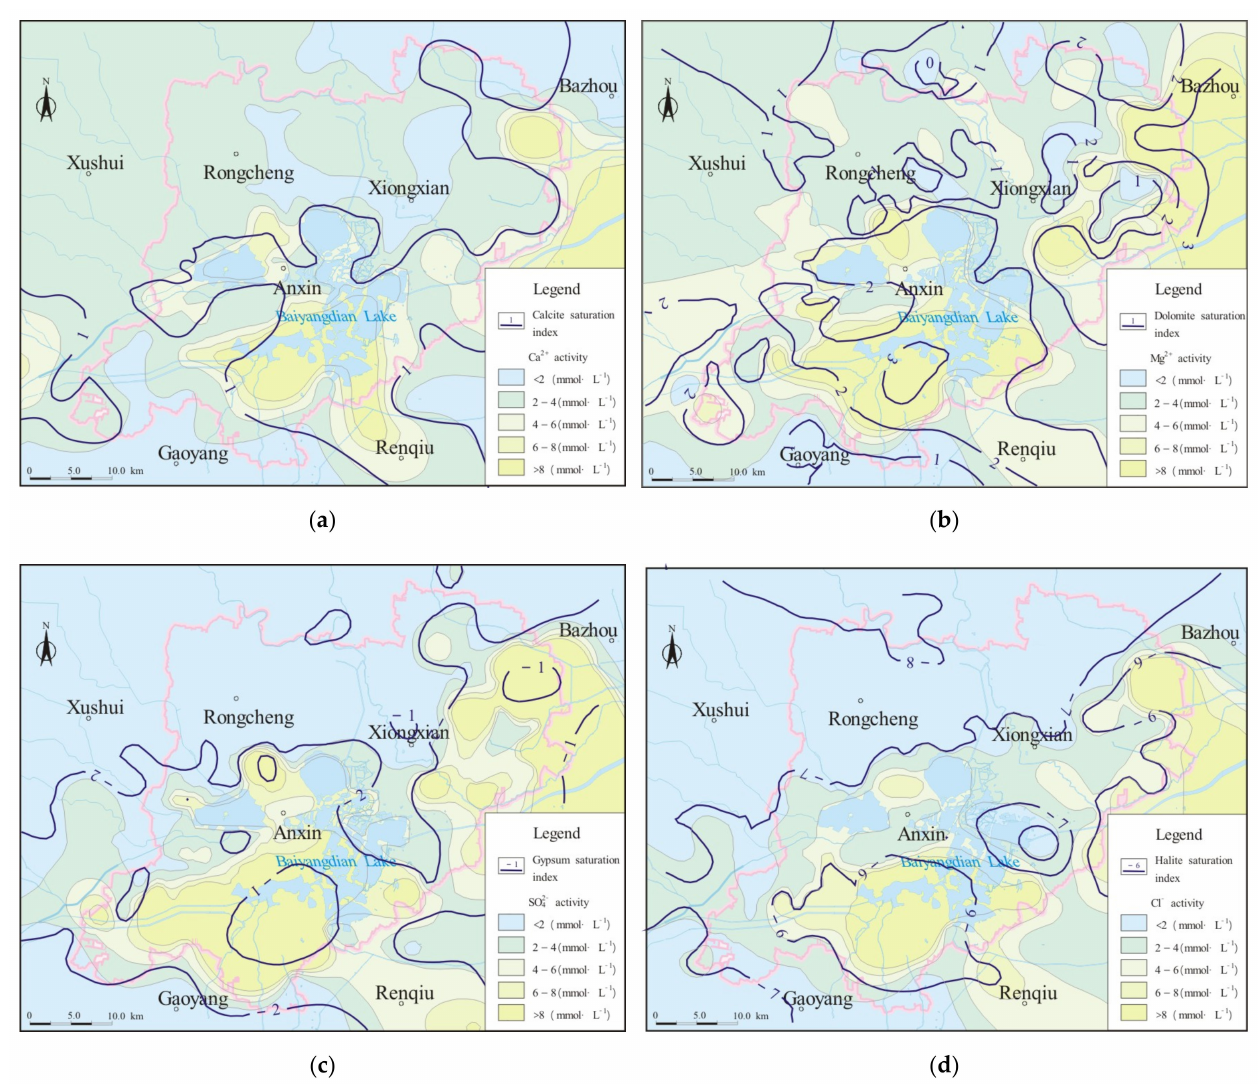
Figure 6. Isoline maps of ionic activity and mineral saturation indices (black dotted lines) for ( a ) calcium (Ca 2+ ) and calcite, ( b ) magnesium (Mg 2+ ) and dolomite, ( c ) sulfate (SO 42 − ) and gypsum and ( d ) chloride (Cl − ) activity and